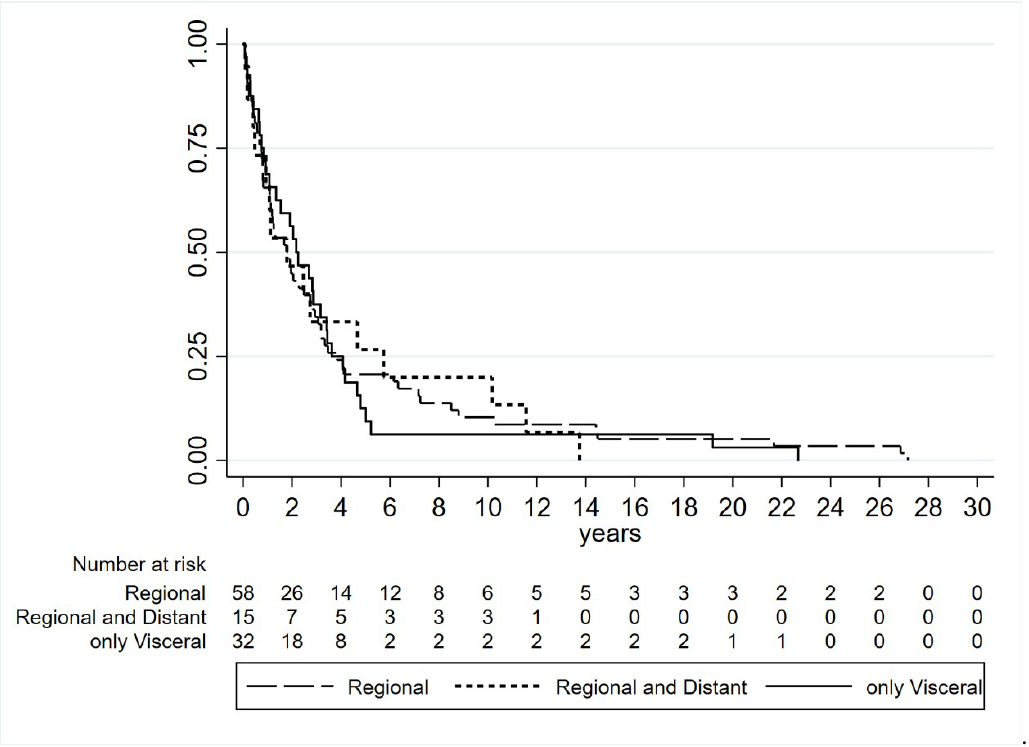
Figure 1. Time to relapse based on type of site of disease relapse (log-rank test p = 0.9564).